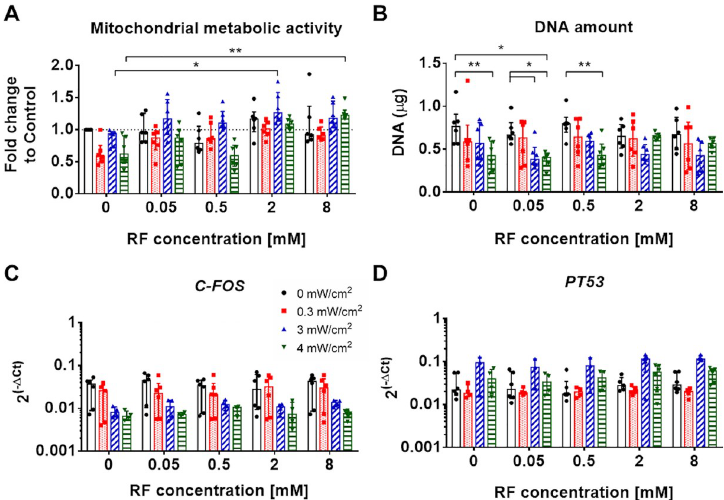
Fig 6. Viability analysis of AF cells 24 hours after Riboflavin (RF) and UVA light treatment. A) Mitochondrial metabolic activity normalized to the DNA amount and the untreated control group (DMEM alone; control = 1, dashed line). B) mRNA expression of bovine C-FOS and PT53 normalized to GAPDH housekeeping gene. Results are presented as median ± IQR (n = 4–6; 2 biological replicates and 2–3 experimental replicates). Kruskal-Wallis test was used for statistical analysis of mitochondrial metabolic activity and C-FOS and PT53 gene expression, whereas two-way ANOVA was used for the statistical analysis of DNA amount, � ,P < 0.05, �� ,P < 0.01.